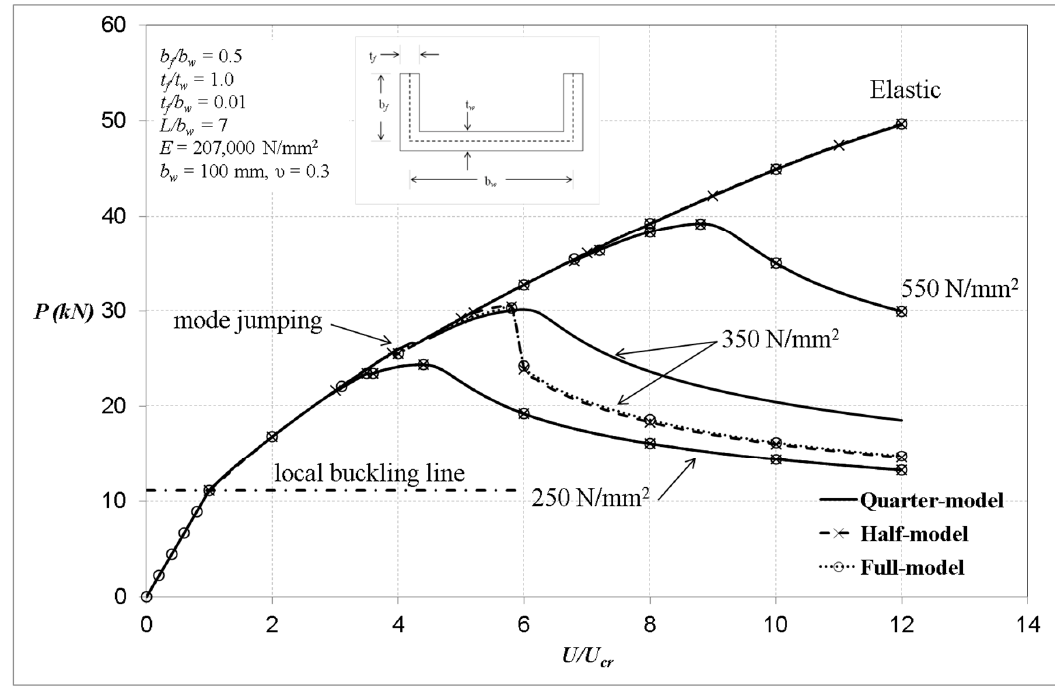
Figure 7. Columns with local buckle crest at column centre section (locally rotationally constrained).